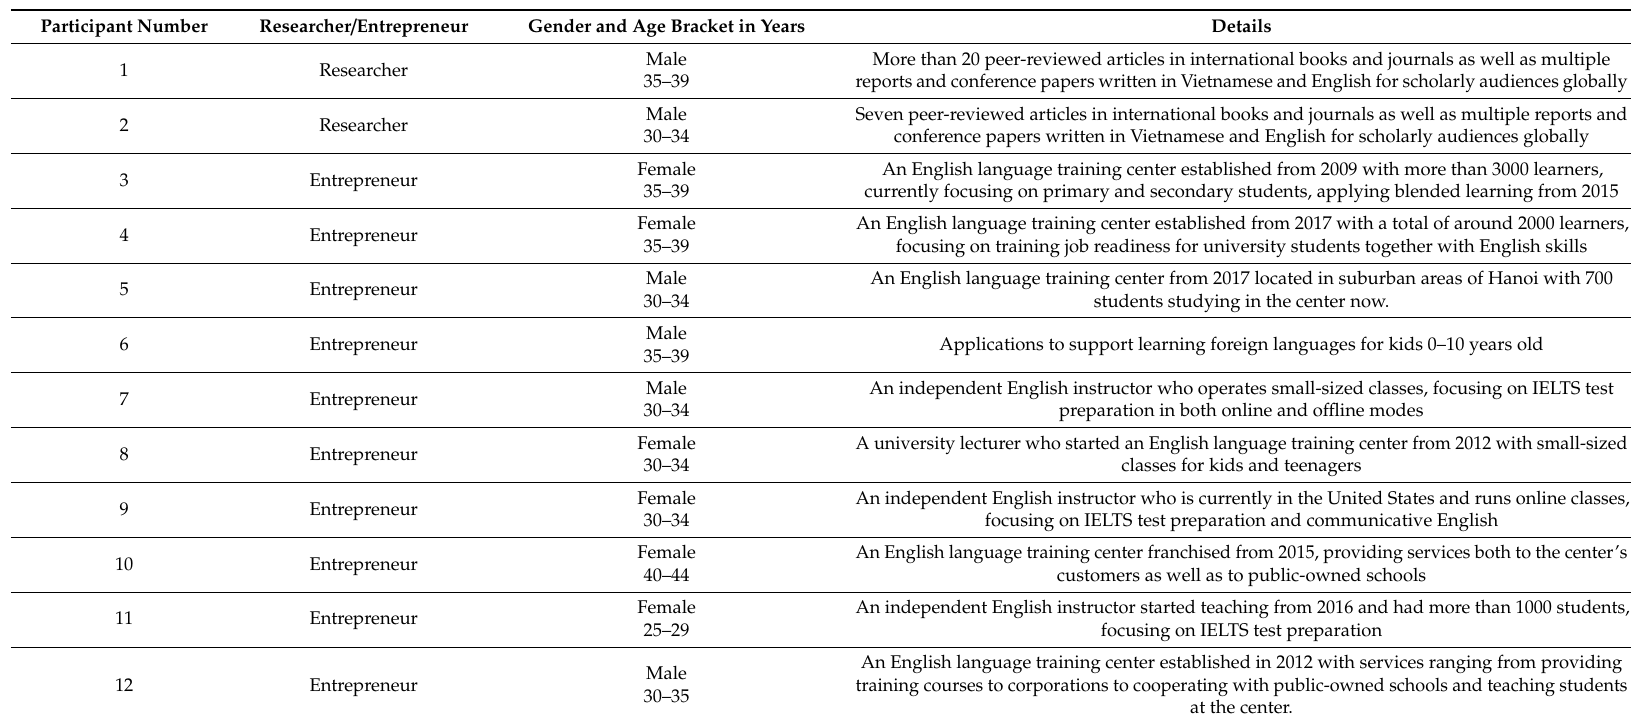
Table A1. Profile of